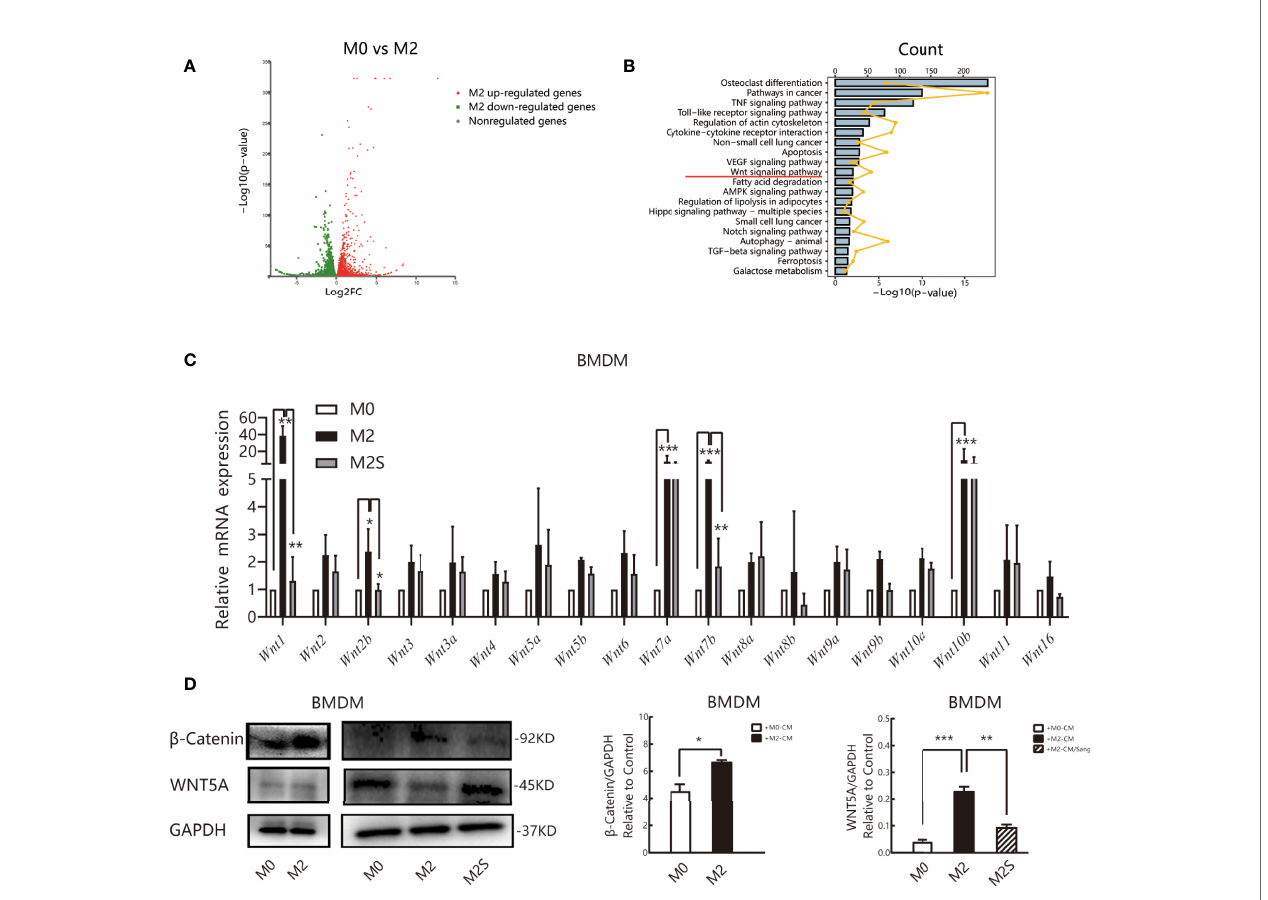
FIGURE 5 | Sang regulates the M2 phenotype of macrophages by the WNT/ b -Catenin pathway. RNA sequencing (RNA-Seq) was used to pro fi le genome-wide gene expression and transcriptome changes in M0 and M2 macrophages. |log2FC| >1 and p -value<0.05 were taken as thresholds to screen differential genes. (A) Volcano plot showing the differentially expressed genes (DEGs) in M0 versus M2, n = 3. FC, fold change. (B) KEGG pathway enrichment analysis of differentially expressed genes (DEGs). Each of these blue entries represents a signaling pathway; broken yellow lines indicate the number of differential genes enriched in the pathway. (C) qRT-PCR was performed to determine Wnt ligand expression in M0, M2, and M2S. (D) Western blot assay for WNT5A and b -Catenin in M0, M2, and M2S, are considered to be key proteins in the non-classical and classic WNT/ b -Catenin pathway, respectively. * p < 0.05; ** p < 0.01; *** p <